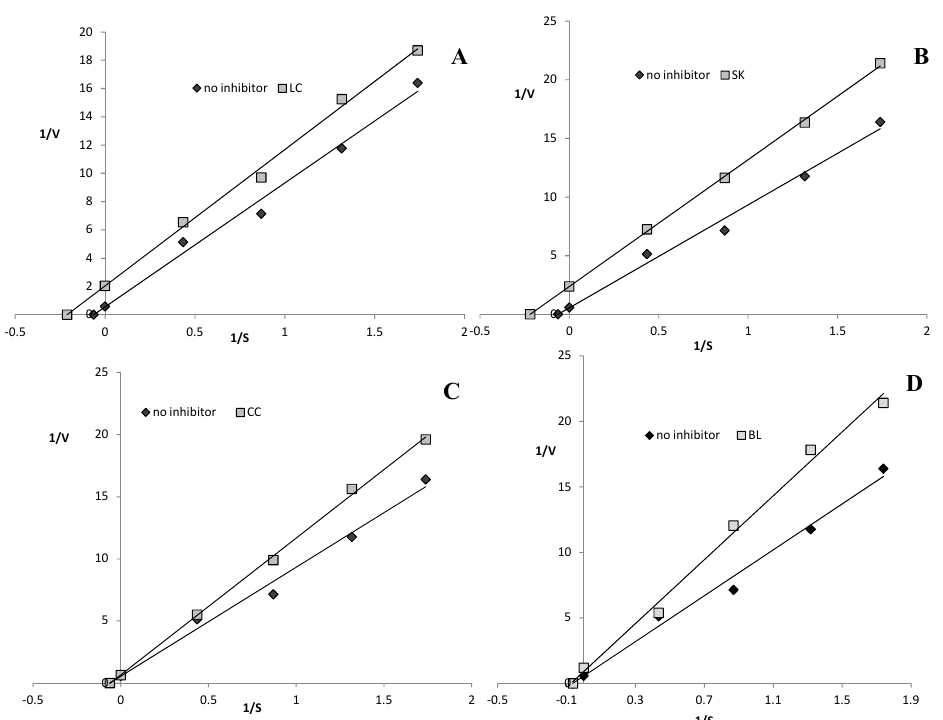
Figure 6. Mode of xanthine oxidase inhibition by extracts from red chard ( A ), white beetroot ( B ), red beetroot leaves ( C ), and white chard ( D ). LC—red chard; SK—white beetroot; CC—red beetroot leaves; BL—white chard.